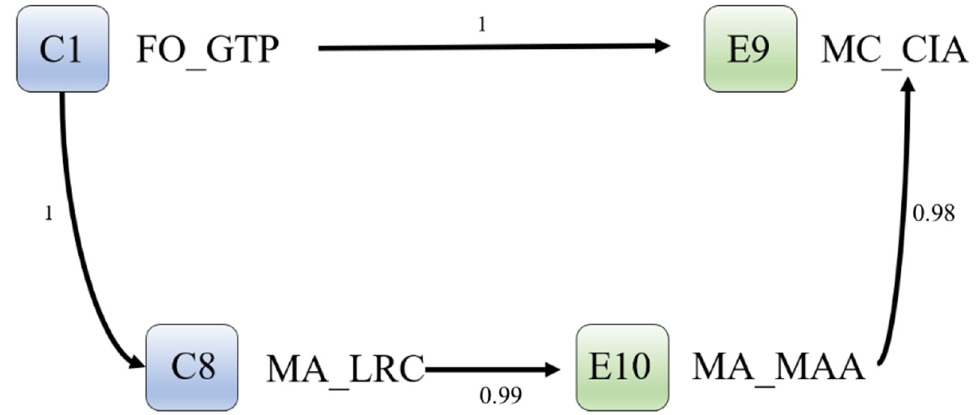
Figure 4. Incidences between operating frequency and mobilization of knowledge C 1 → E 9 . Source: